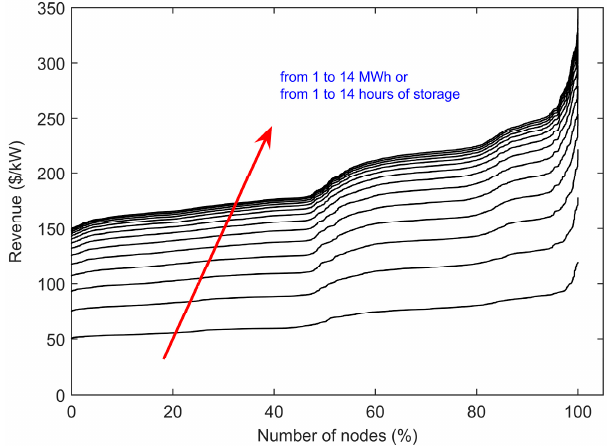
Figure 15. Potential revenue in RTM in 2008 from 1 to 14 MWh, considering 7395 nodes with price-taking and perfect forecast.